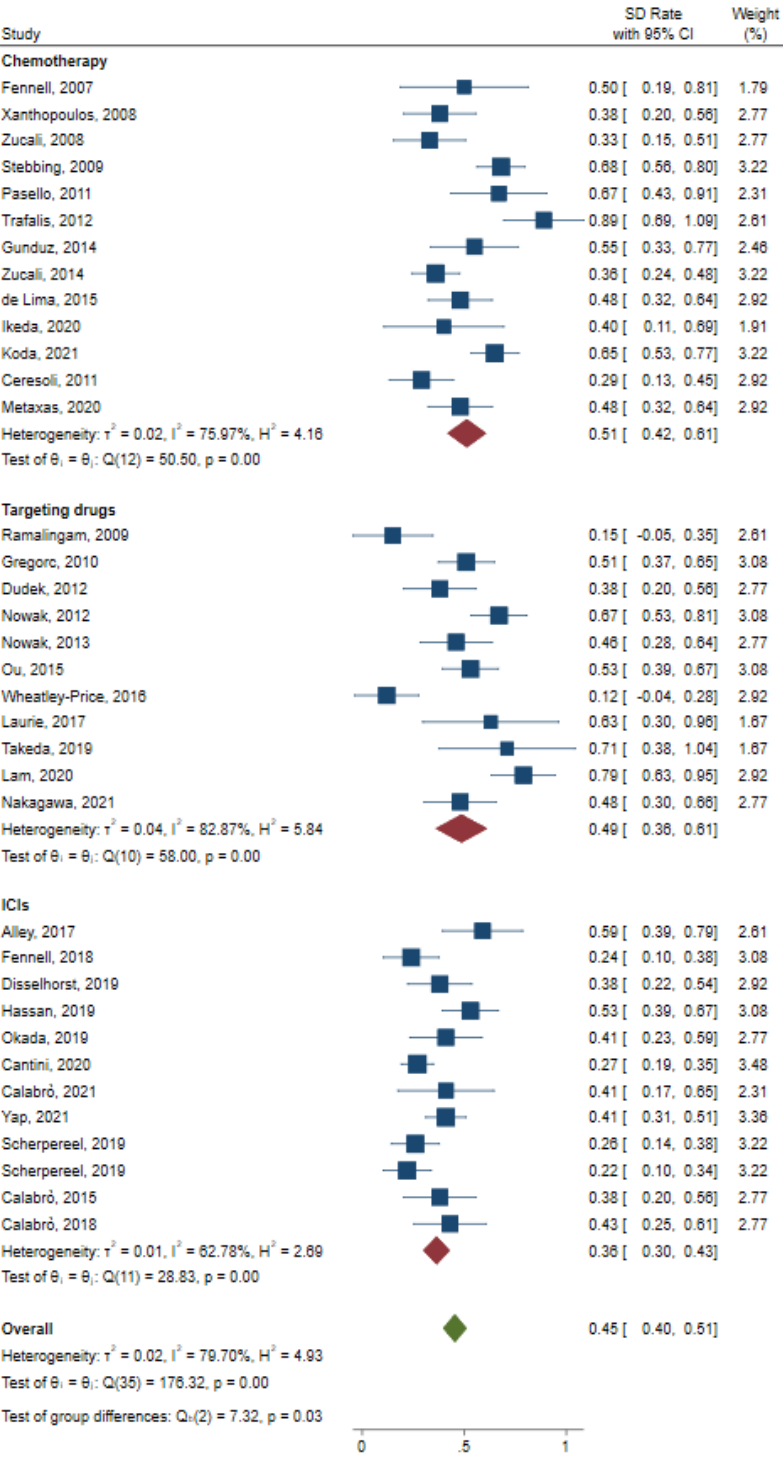
Figure 6. Pooled analysis of SD rate for chemotherapy, ICIs, and targeting drugs [7,9 – 13,15 – 25,27 – 32,34 – 41,43,46,47,49] . Overall, the PD rate was still in favor of chemotherapy treatment, with a PD rate of 0.39 (95%CI: 0.31 – 0.48, Figure 7). The overall PD rates of the other two treatments were 0.46 (95%CI: 0.32 – 0.61, Figure 7) and 0.44 (95%CI: 0.36 – 0.52, Figure 7) for targeting drugs and ICIs, respectively.